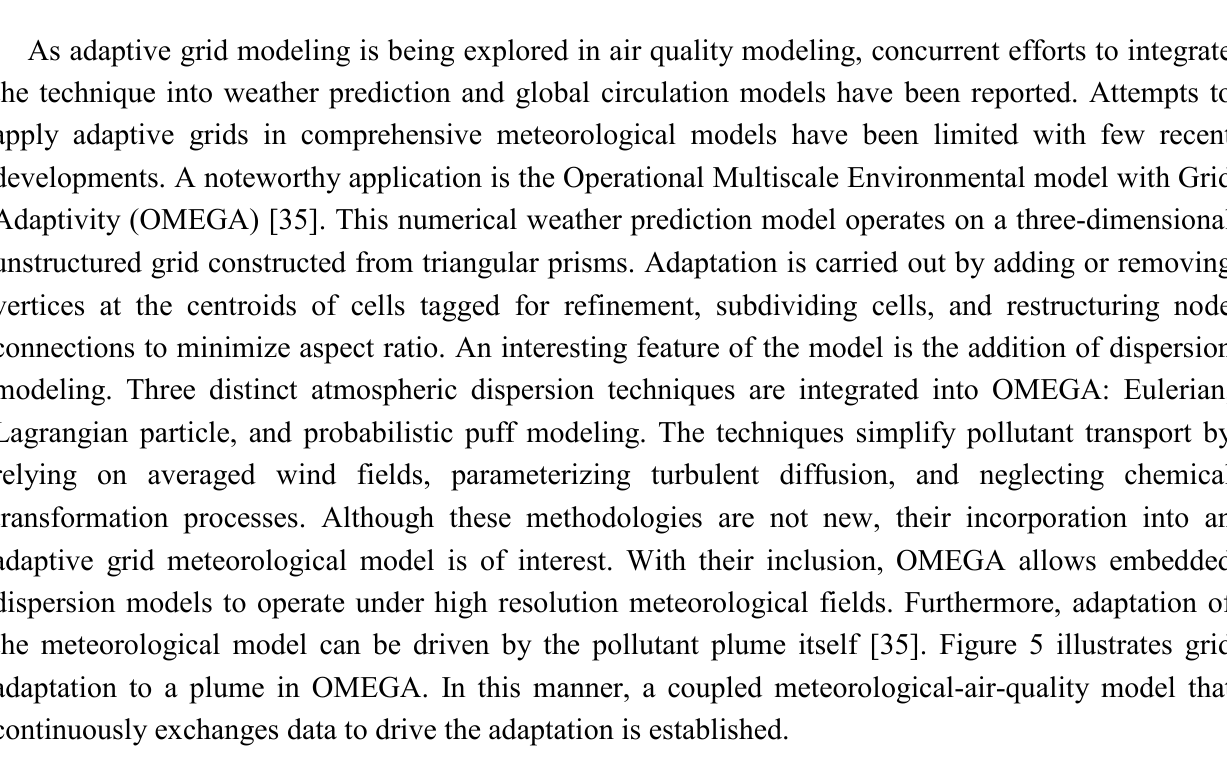
Figure 5. OMEGA grid dynamically adapted to a pollutant plume. Reprinted with permission from